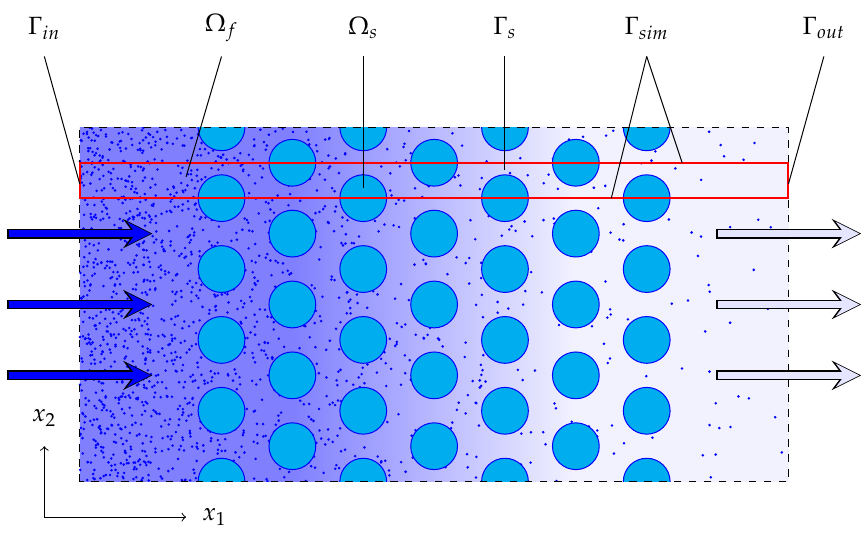
Figure 1. Sketch of the pore scale